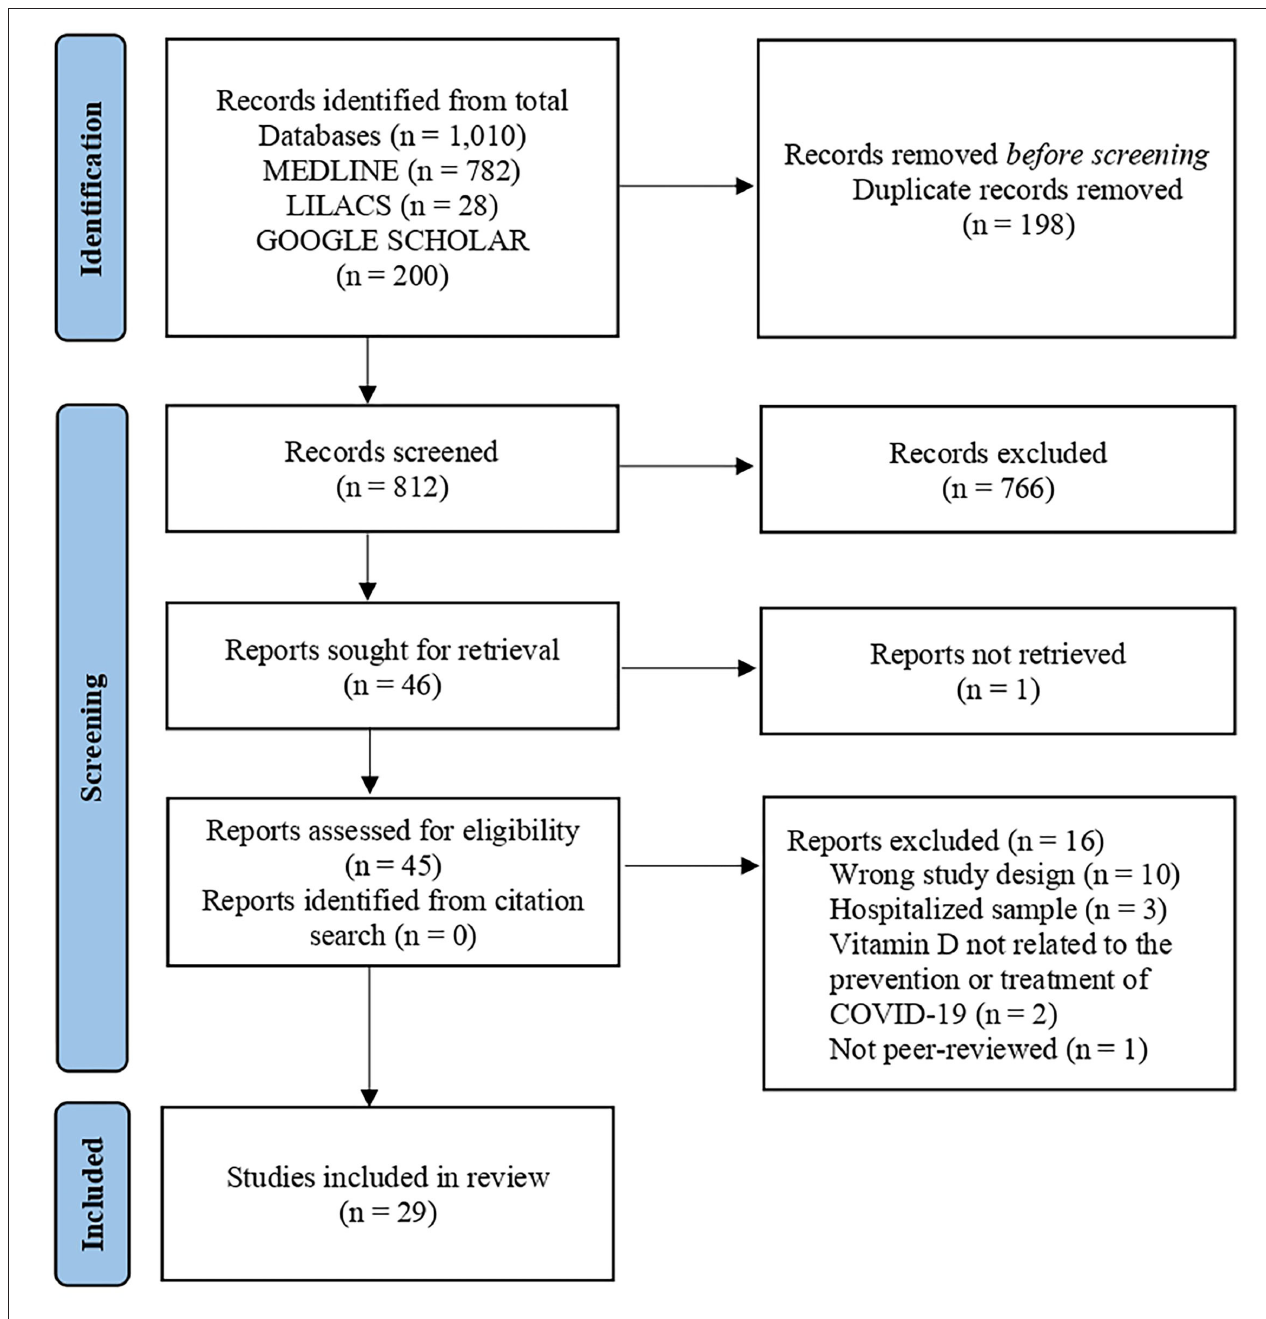
FIGURE 1 | PRISMA study flow diagram for search up to August 24,